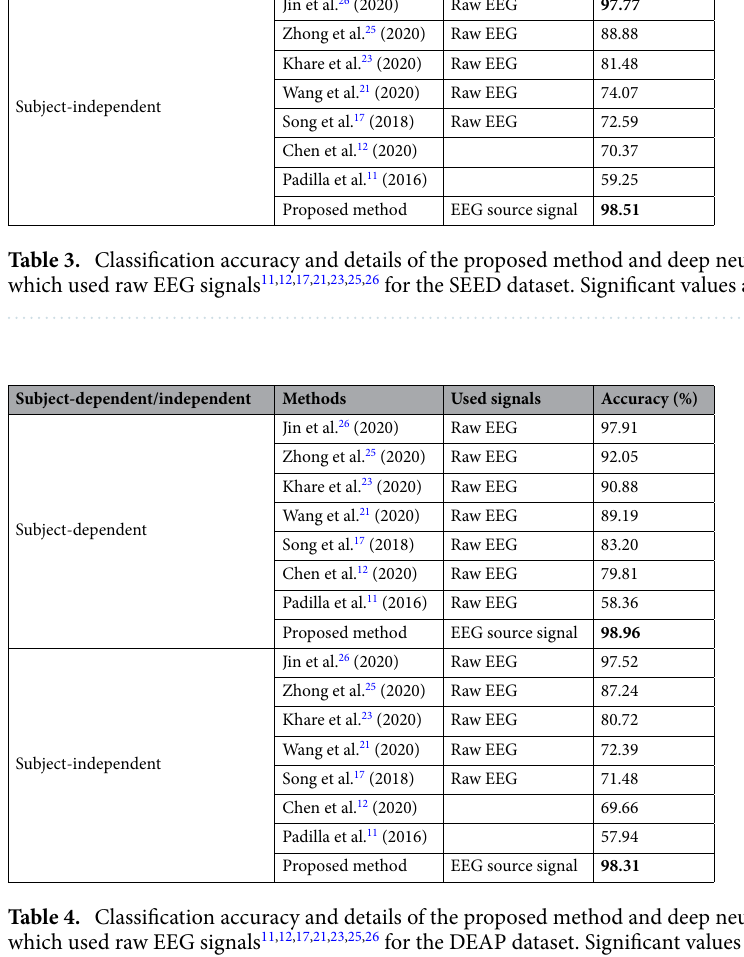
EEG source localization